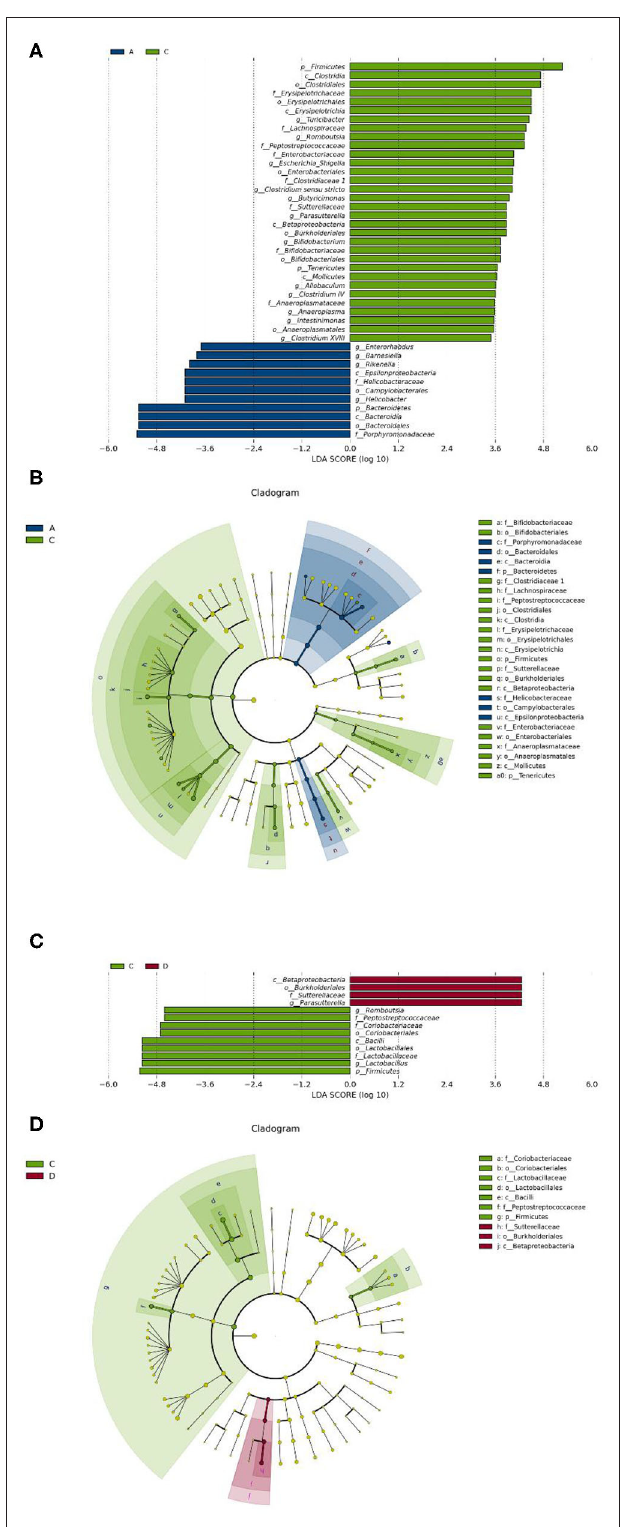
FIGURE 6 | Se-enriched L. acidophilus changes the intestinal microbiota. (A) Marker bacteria (LDA score > 2) between the control group (group A) and